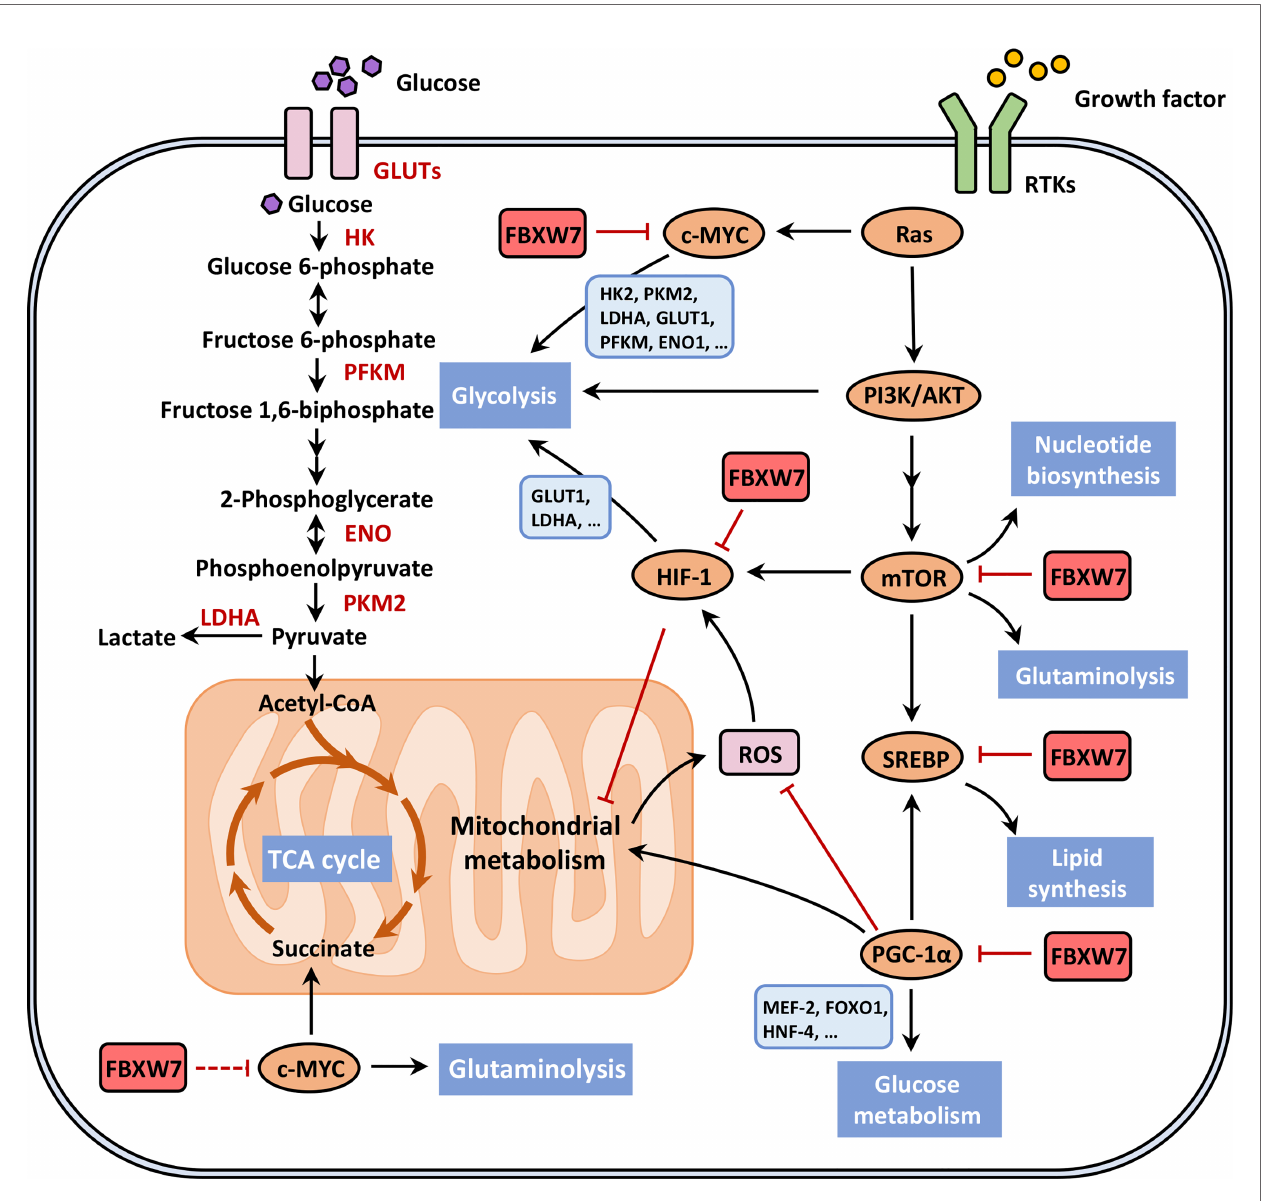
FIGURE 3 | FBXW7 participates in the reprogramming energy metabolism. The rewired metabolic network favors cancer cells to meet essential energy, anabolic and redox demands on acquired nutrients during early stages of cancer development, where FBXW7 modulates metabolic reprogramming through ubiquitin- dependent degradation of crucial metabolic molecules, such as mTORC1, SREBP, HIF-1, c-MYC and PGC-1 a , their relationship seen in red solid blocking arrows. We are awaiting the potential roles of FBXW7 in regulating tricarboxylic acid (TCA) cycle and glutamine metabolism through interacting with c-MYC, so the red dotted line blocking arrow is shown in the lower left part of the fi gure. This fi gure was adapted from DeBerardinis and Chandel (118). ENO, enolase; FOXO1, fork head box O1; GLUT, glucose transporter; HK, hexokinase; HNF-4, hepatic nuclear factor-4; LDHA, lactate dehydrogenase A; MEF-2, myocyte enhancer factor-2; PFKM, phosphofructokinase; PKM2, pyruvate kinase M2; ROS, reactive oxygen species; RTK, receptor tyrosine